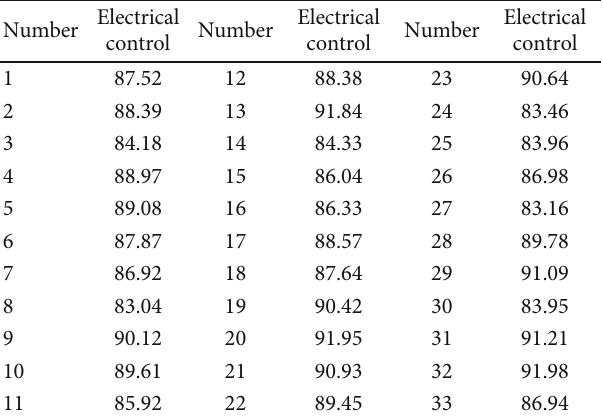
Figure 8: Parameter optimization range of traditional optimization graph. Table 1: The e ff ect of electrical automation control system based on intelligent computer algorithm.